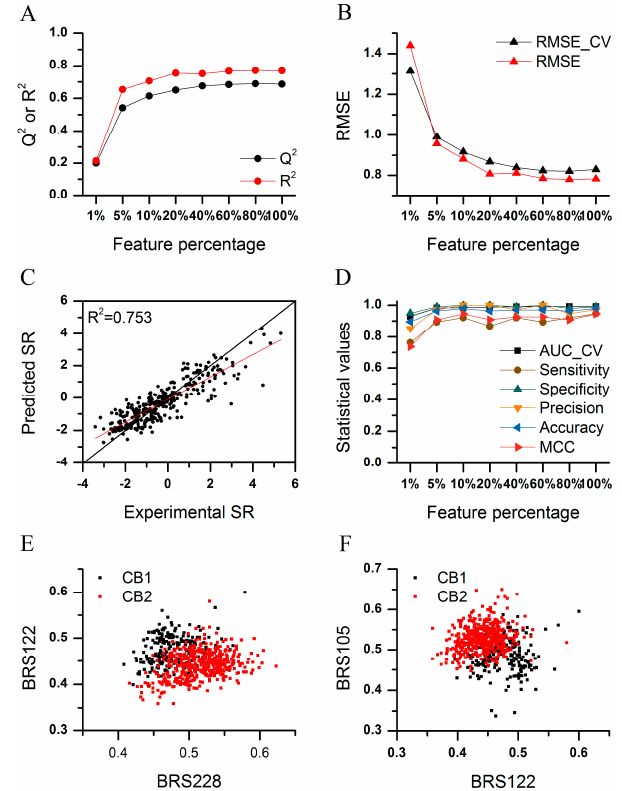
Figure 5. The CB 1 /CB 2 subtype selectivity prediction models. ( A ) Cross-validation Q 2 and test set R 2 of the regression models with different feature subsets; ( B ) cross-validation and test set RMSE of the regression models with different feature subsets; ( C ) relationship between experimental and predicted SR of the model with 20% BRS-3D features; ( D ) discriminant models with different feature subsets; and ( E , F ) distribution of the selective compounds in the chemical space, composed of the